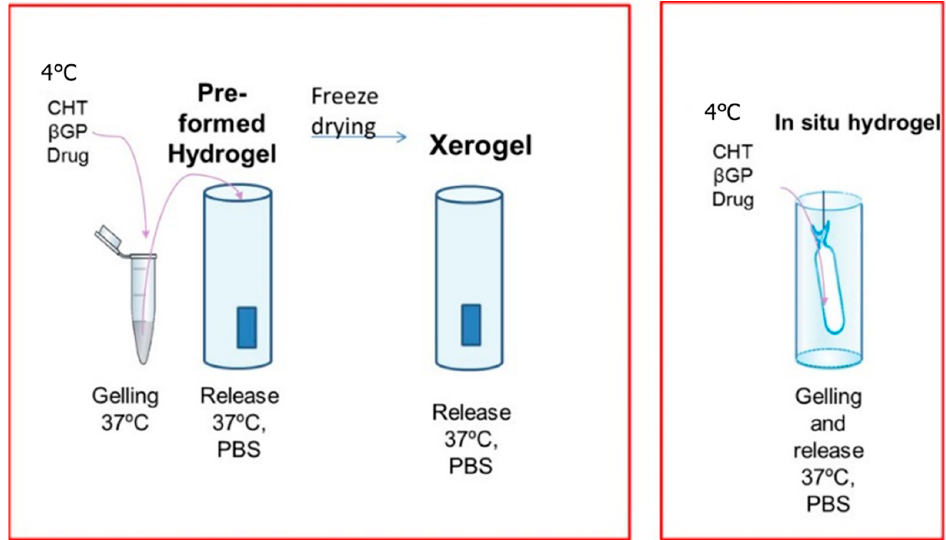
Figure 4. Risperidone formulations.